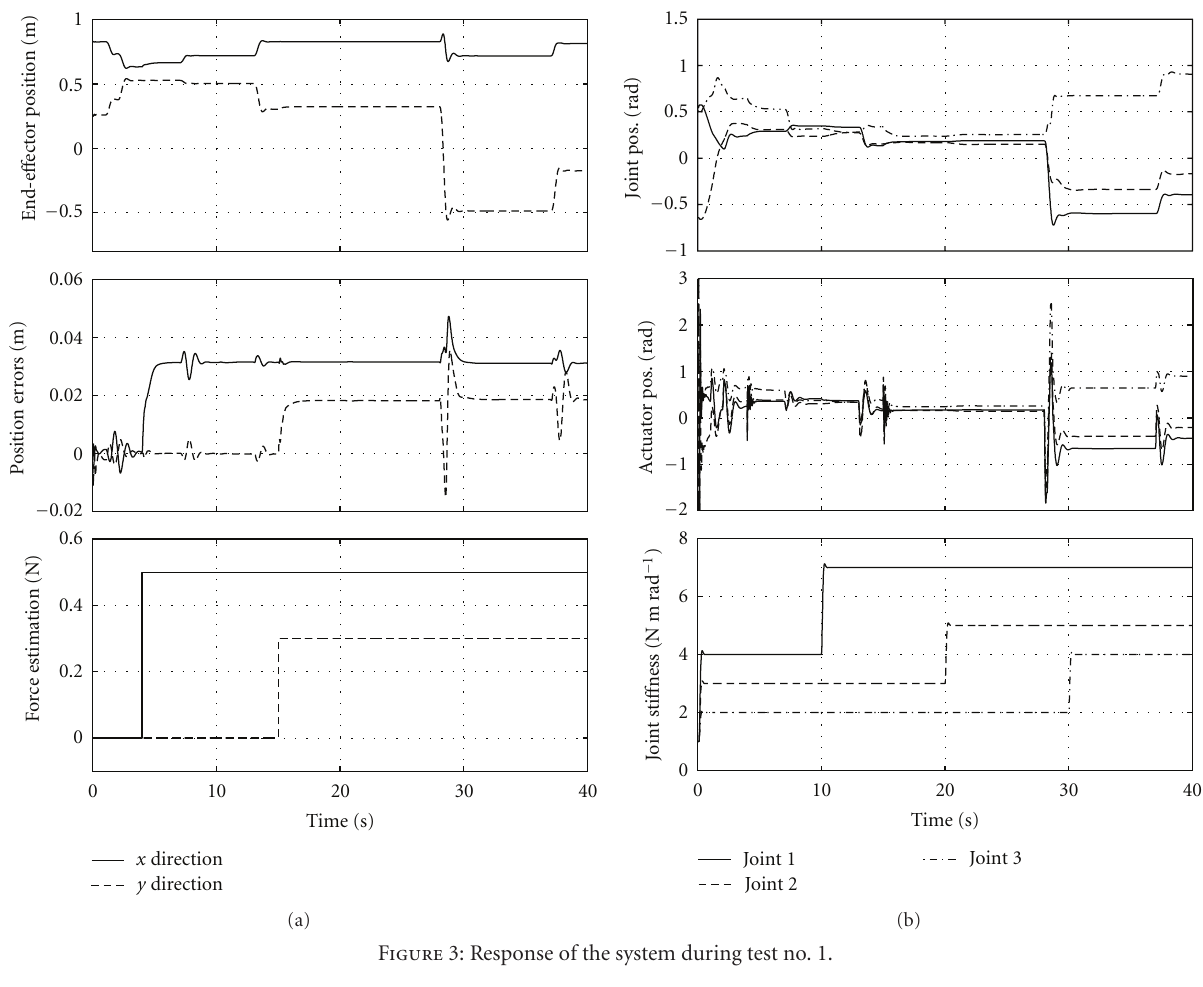
Figure 3: Response of the system during test no.